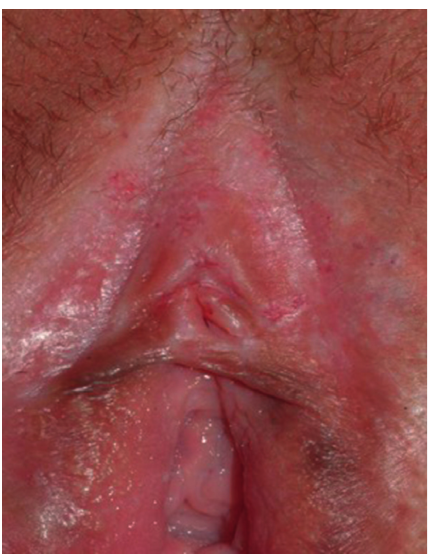
Figure 2: Early stage of vulvar lichen sclerosus with glistening white